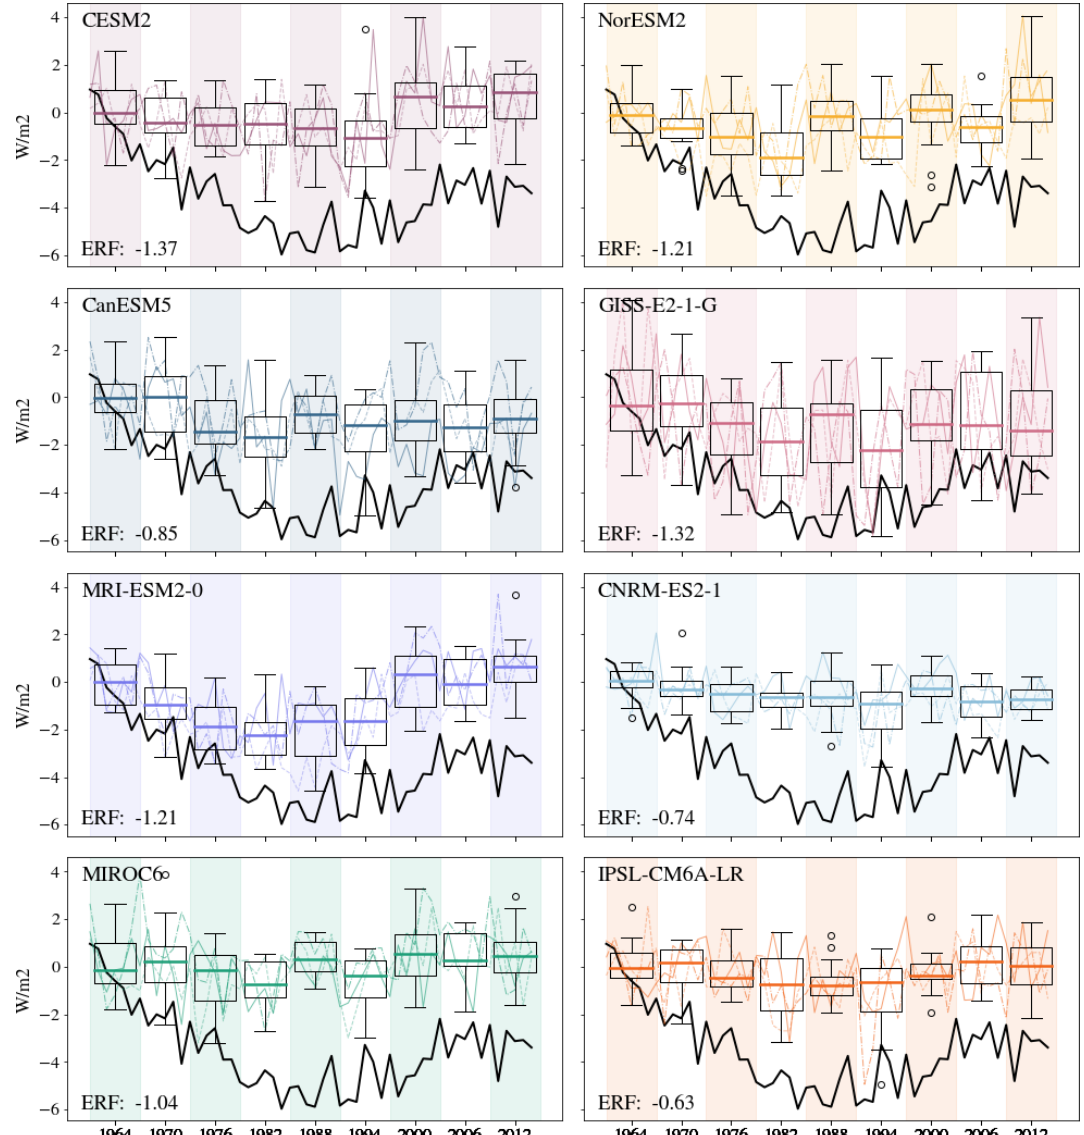
Figure 1. Global surface downwelling shortwave radiation (SDSR) anomaly at the surface for GEBA (black) and three ensemble members for the historical simulation of the eight models in this study. The boxes are made for 6-year intervals (shaded in background) based on 6-yearly means and three ensemble members per model. Colored lines behind boxes show yearly values of SDSR anomaly per ensemble member. The height of each box represents the interquartile range of the data, and the thick colored line within each box is the median. The whiskers show the minimum and maximum values of the selection of data, and the outliers are shown as a hollow dot. Results are co-located to all GEBA stations (1487) throughout the time period. The aerosol ERF as found in Smith et al. (2020) per model is shown in the bottom left of each